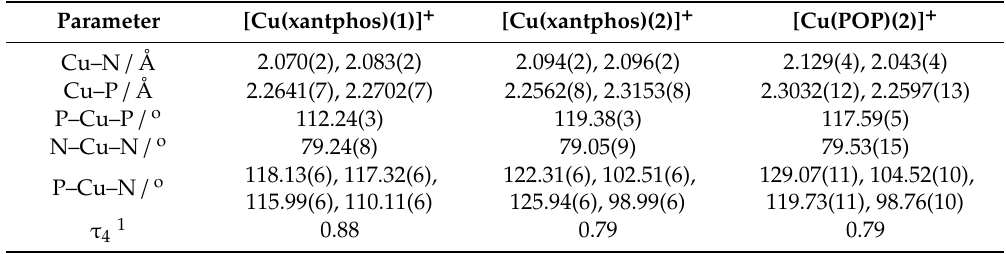
Table 1. Bond lengths and angles in the coordination sphere of each [Cu(PˆP)(NˆN)] +